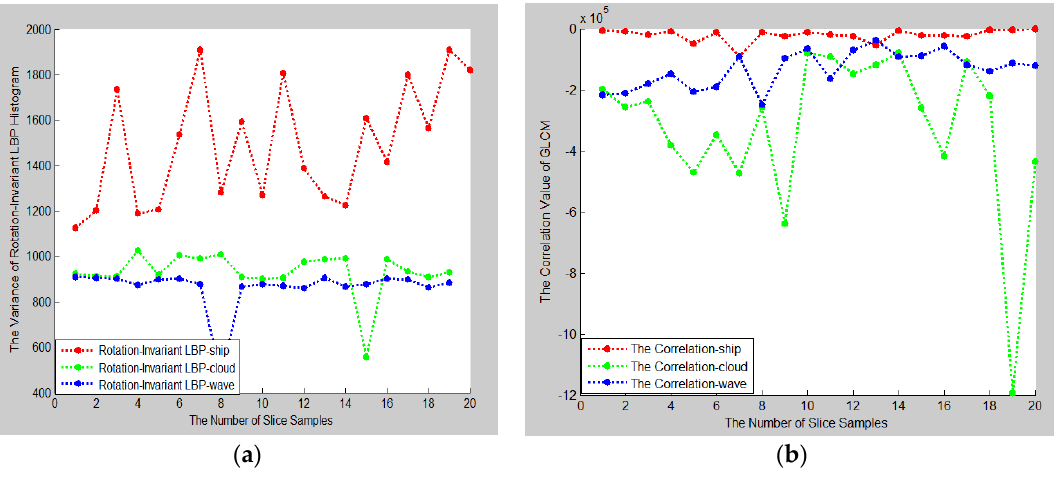
Figure 14. The results of the feature statistical experiment. ( a ) The histogram variance of LBP riu 2 and ( b ) the correlation of GLCM.